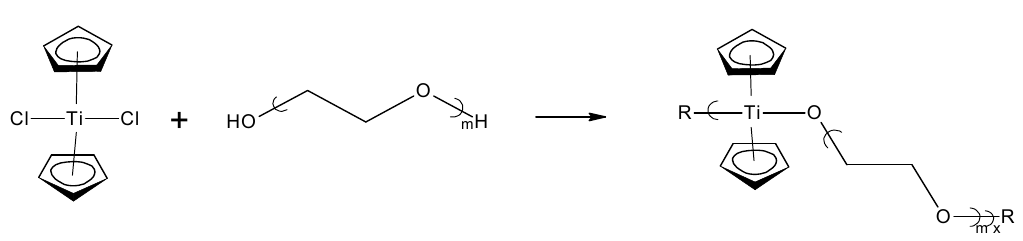
Figure 2. Synthesis of titanocene polyethers from reaction of titanocene dichloride and PEG, where R is a simple chain extension.